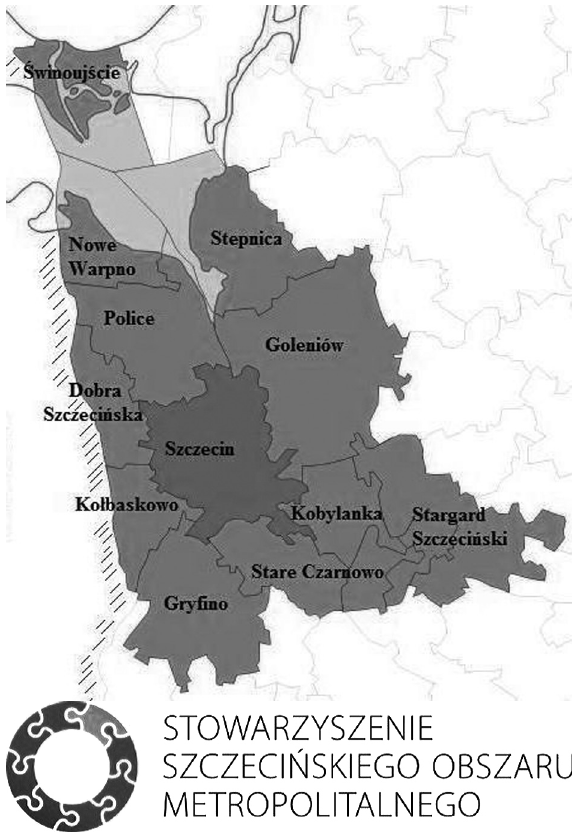
Fig. 1. Communes of the Szczecin Metropolitan Area Asso - ciation in 2013. Source: